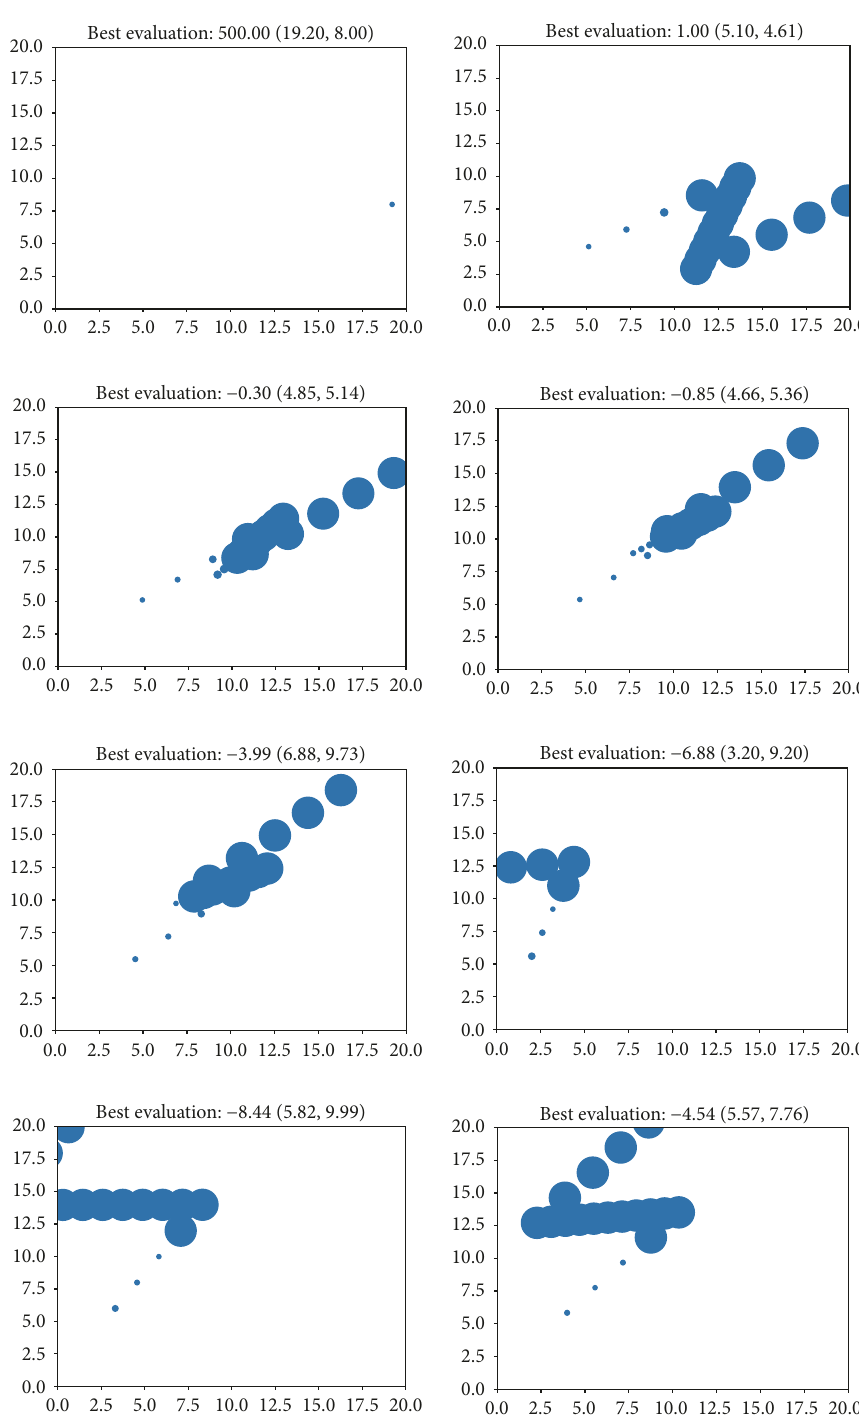
Figure 4: Cycles of SDN from left to right, top to bottom. Performance is indicated at the top of the plots, with the sizes of the evaluated locations inversely proportional to the value of the loss function (and scaled per plot). The figure shows that the smallest loss value, in a 2% vicinity of the minimum, was found as early as in the 7th cycle, without recourse to any kind of gradient